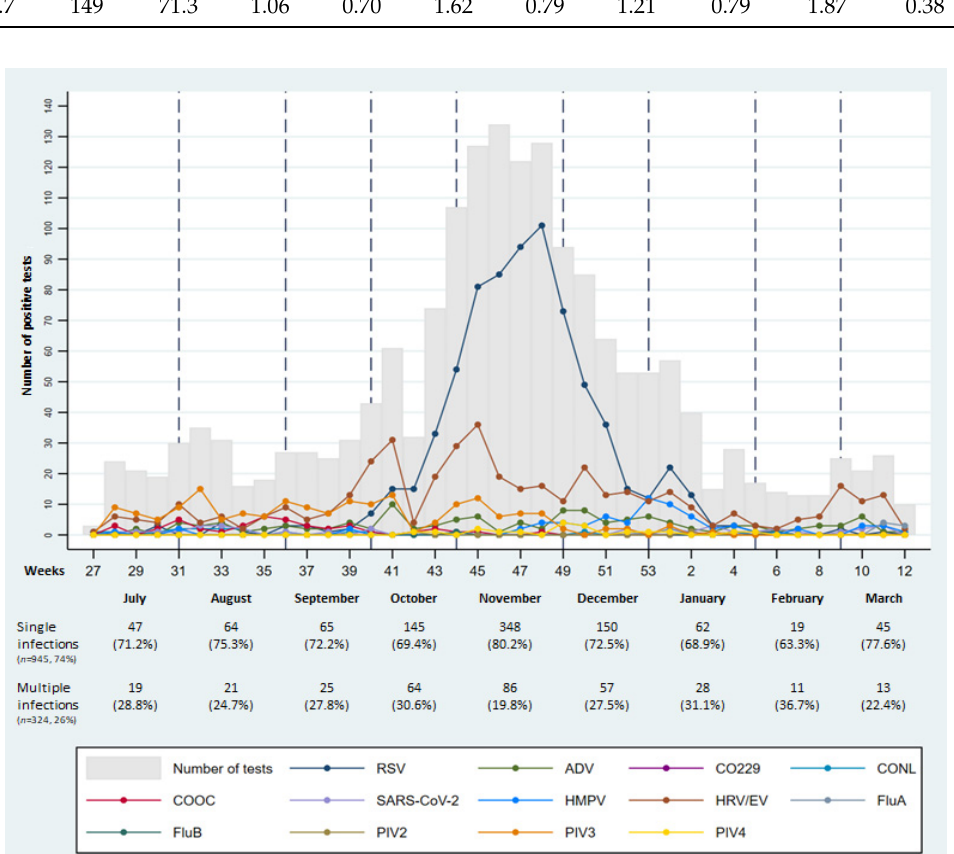
Figure 2. Pathogen distribution according to weeks of observation (from 1 July 2021 to 31 March 2022) and distribution of single versus multiple infections according to months of observation.